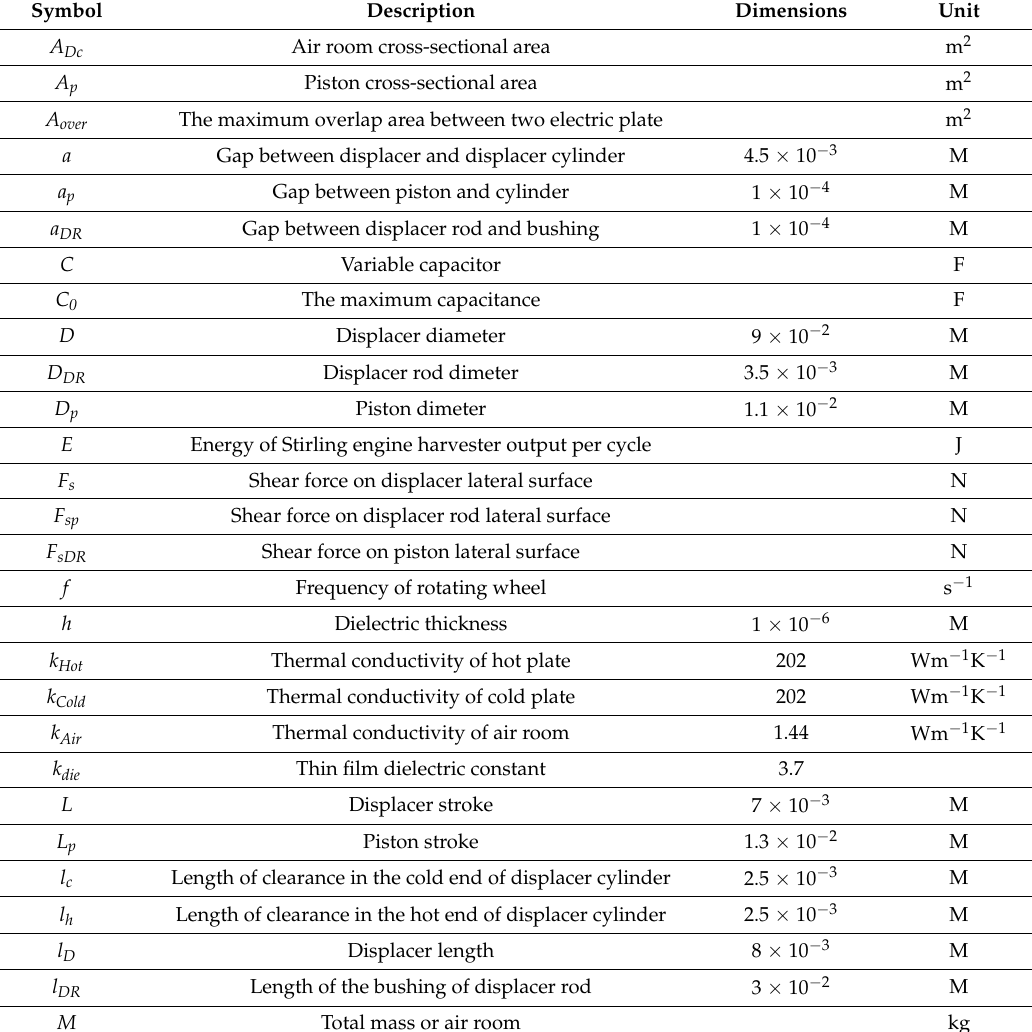
Table A3. Nomenclature and dimensions of Gamma-type Stirling engine